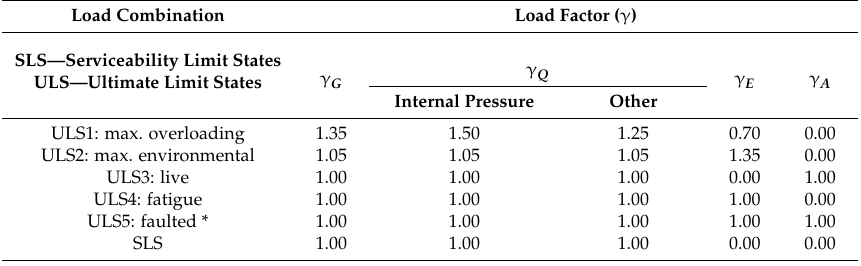
Table 2. Load factors according to the Canadian code (adapted from CSA-Z662, 1996).